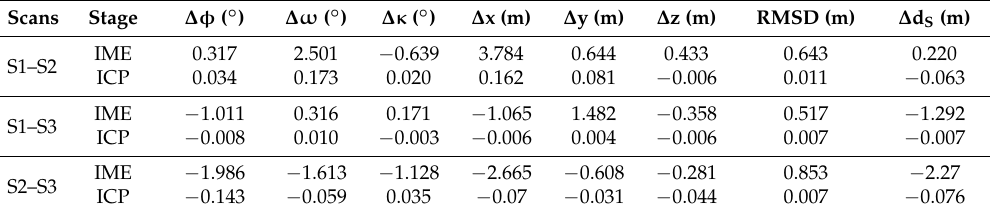
Table 3. Errors between estimated and reference transformation parameters: ∆ φ , ∆ ω and ∆ κ are rotation parameter errors corresponding to the x, y and z axes, respectively; ∆ x, ∆ y and ∆ z are translation errors along the x, y and z axes, respectively; RMSD is the root mean square deviation between two point clouds; and ∆ d S is the error of the distance between two adjacent scan